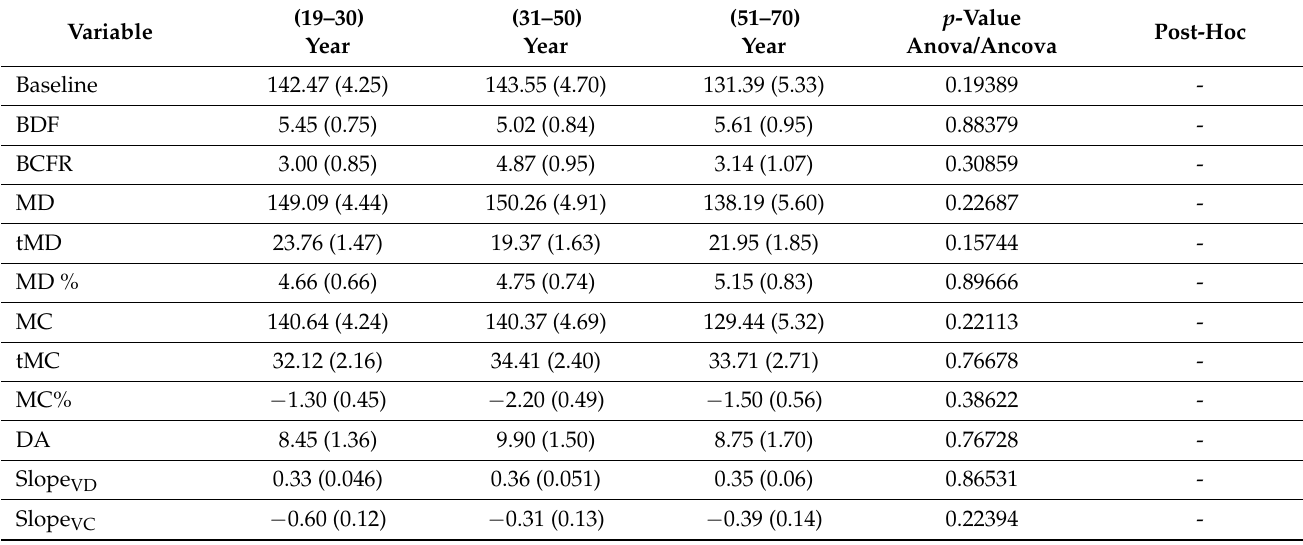
Table 3. Summary of retinal venous vascular function